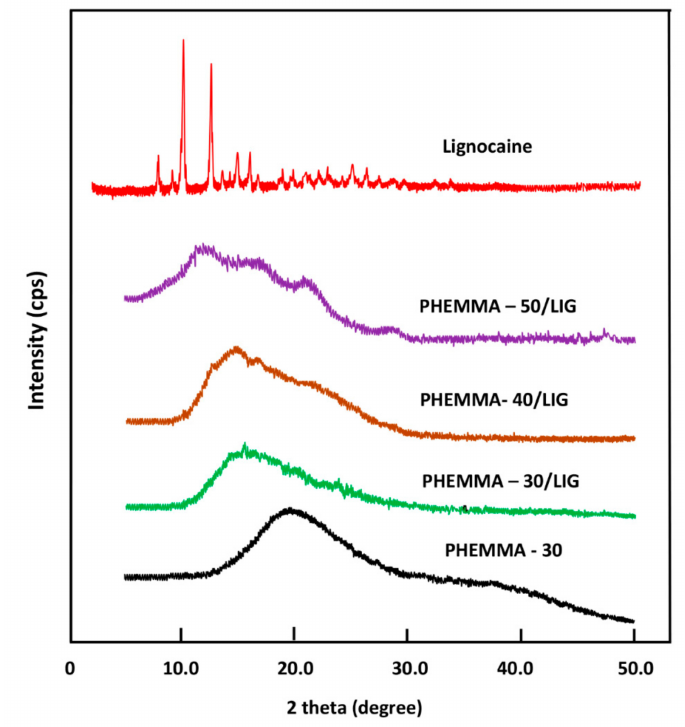
Figure 6. XRD patterns of pure LIG, PHEMMA, and PHEMMA / LIG systems with different MMA